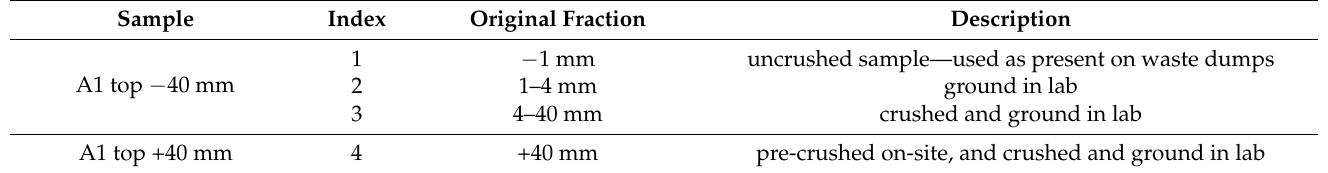
Table 2. Prepared samples − 1 mm for comparative gravity concentration